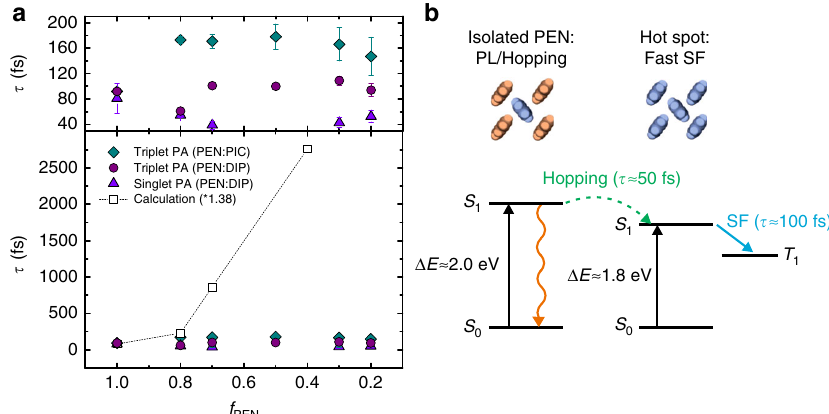
Fig. 6 Singlet fi ssion time constants and proposed model. a Comparison of experimental results (decay times of the singlet PA extracted at 607 nm in PEN: DIP and build-up times of the triplet PA extracted at 875 nm in PEN:DIP and PEN:PIC, respectively) with the calculated SF rate based on the model discussed. The upper panel shows the experimental time constants in the lower panel with an expanded scale. The error bars indicate the uncertainty of the fi t. The results of the calculations have been scaled by 1.38 to match the experimentally determined SF time constant of pure PEN. Deviations between model and experiment are discussed in the text. b A schematic sketch of the potential origin of the deviations of the experimental results from the theoretical predictions showing the two extreme cases of PEN with and without PEN nearest